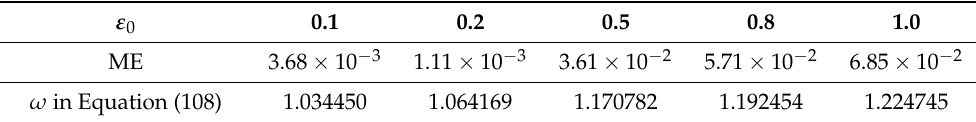
Table 7. The maximum errors (MEs) and frequencies for the analytic solution of Example 7 with different ε 0